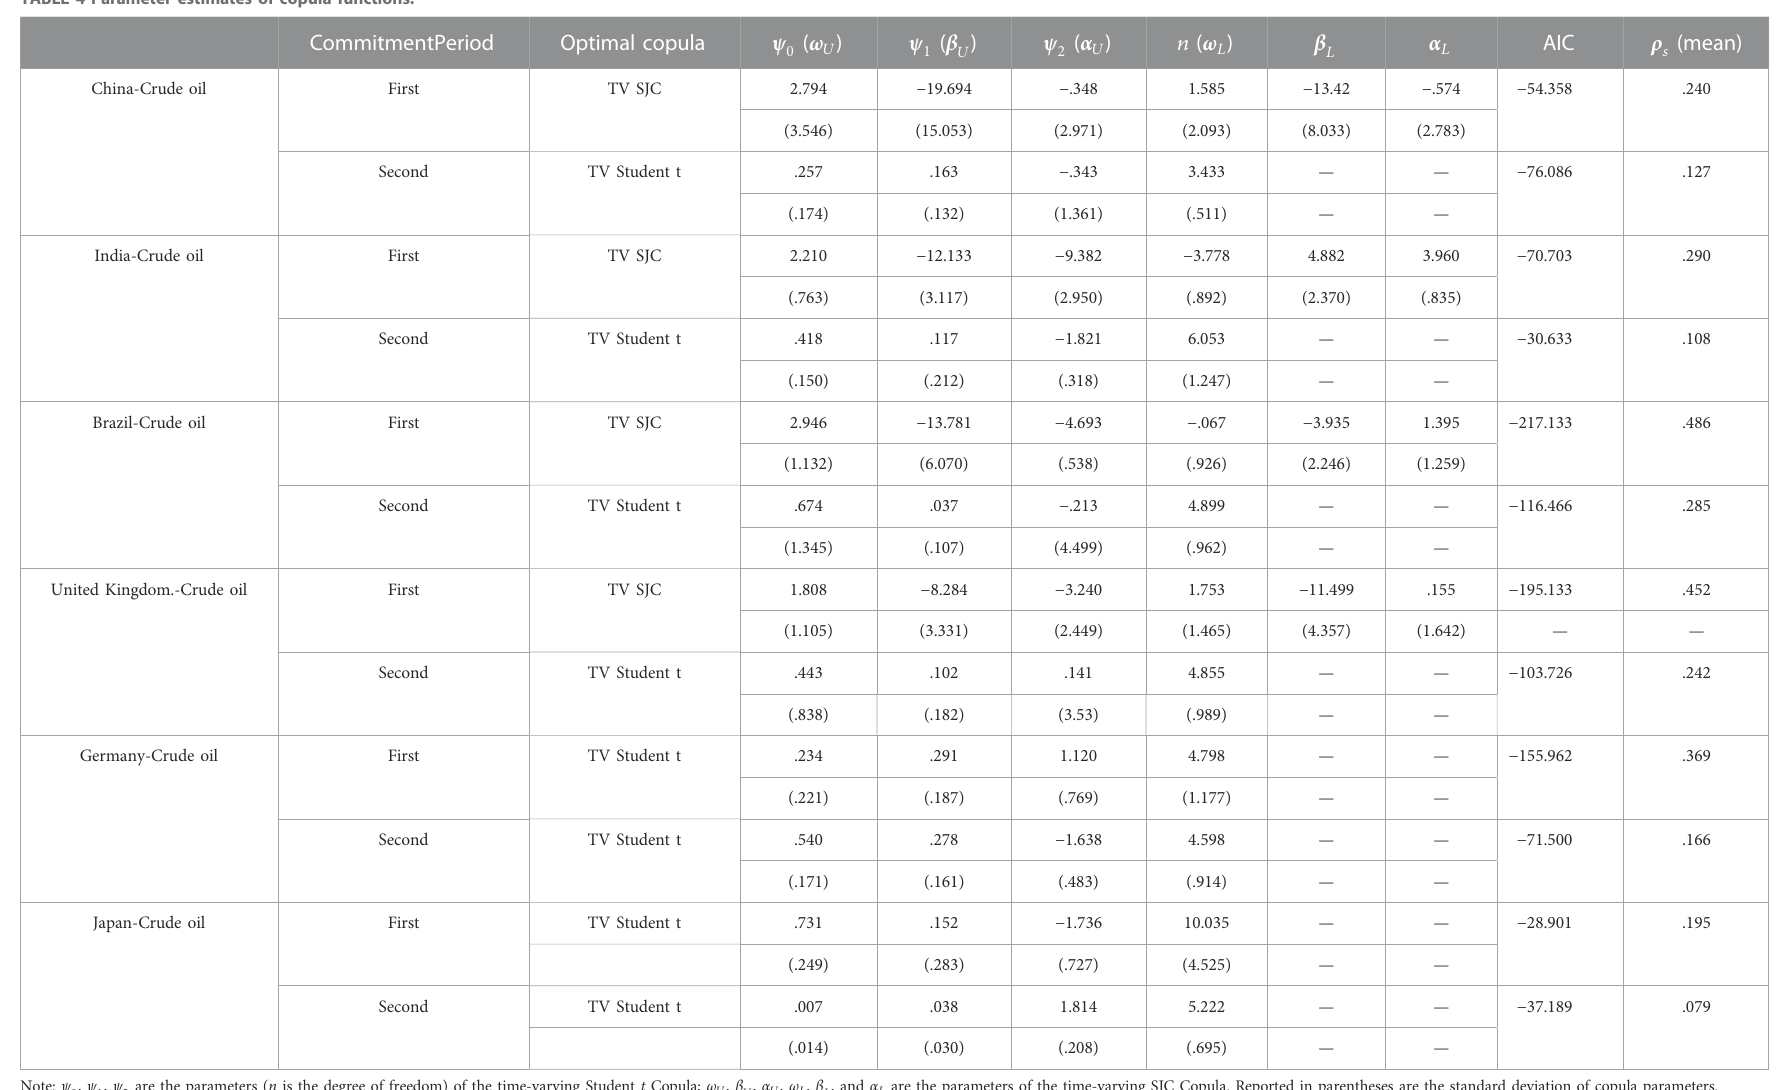
TABLE 4 Parameter estimates of copula